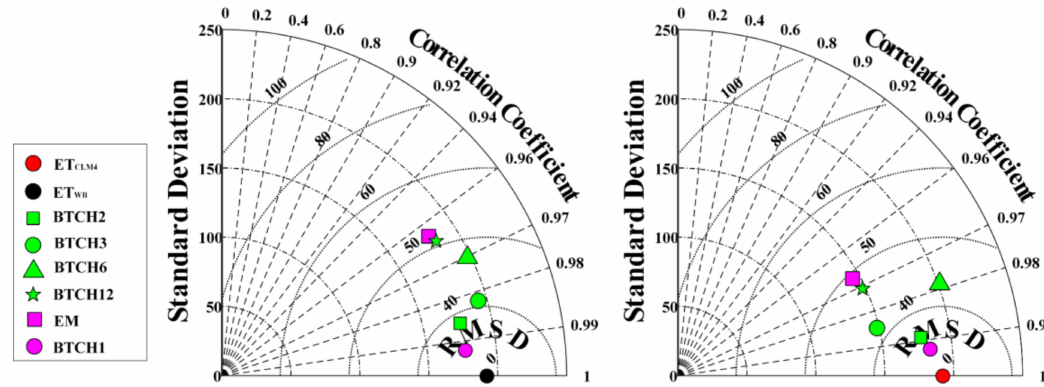
Figure 13. Comparison of evapotranspiration (ET) estimates (1982 to 2011) from the ensemble mean (EM) and Bayesian-based three-cornered hat (BTCH) methods for di ff erent time windows.